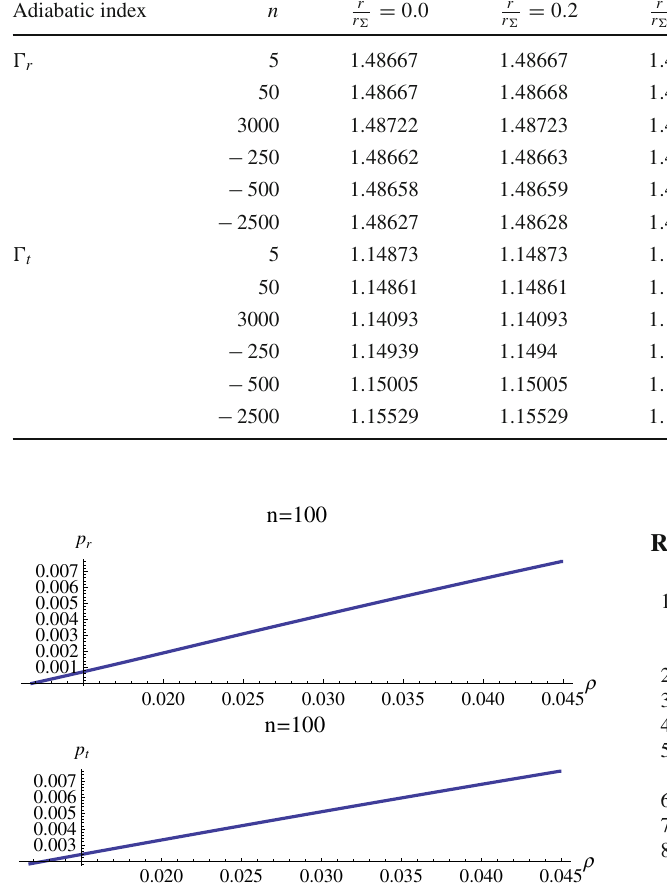
Fig. 9 In this figure we have shown the variation of the radial and transverse pressure with respect to the matter density. (Top) Along x - axis and y -axis we have respectively plotted the matter density ρ in MeVfm − 3 unit and radial pressure p r in MeVfm − 3 unit. (Bottom) Along x -axis and y -axis we have respectively plotted the matter density − 3 unit. Both ρ in MeVfm − 3 unit and transverse pressure p t in MeVfm the profiles are drawn for a compact star of mass M = 1 . 85 M (cid:3) and radius of the star=9 . 5km by fixing b = 0 . 0095 km − 1 . Both the figures are drawn for n =